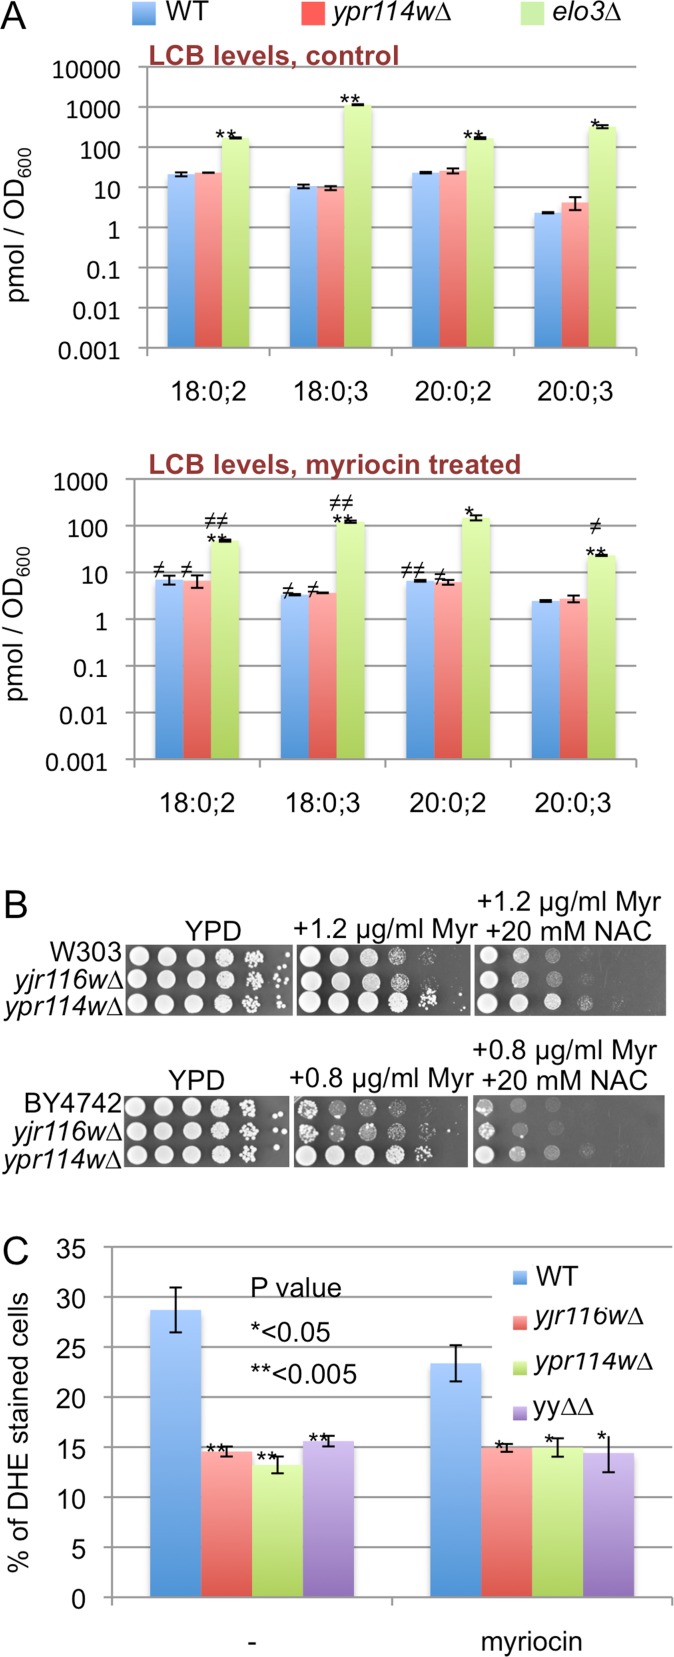
Effect of myriocin treatment on LCB levels.A. Cells growing exponentially in YPD were further incubated without (upper plot) or with 20 μg ml-1 myriocin (lower plot) for 4 hrs and LCB levels in the lipid extracts were determined by ESI-MS. A similar pretreatment with 2 μg ml-1 of myriocin repressed LCB levels of ypr114w∆ and WT to the same degree, albeit less strongly (not shown). B. Plates containing myriocin with or without 20 mM NAC were incubated for 2 days (top sections W303 background, bottom sections BY4742 background). C. Strains in the W303 background were grown in YPD with or without myriocin (1.2 μg ml-1) for 24 h and superoxide anions were detected by staining with DHE. After 24 h all strains had grown to the same density.